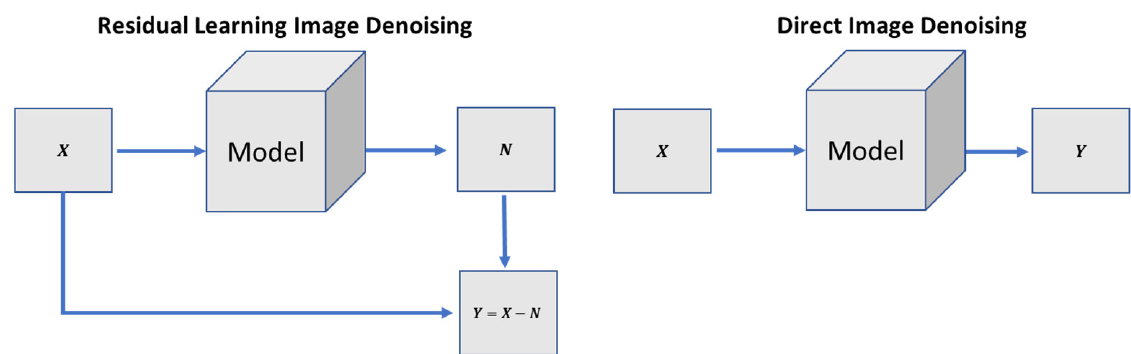
Figure 4. Different approaches for image denoising tasks.